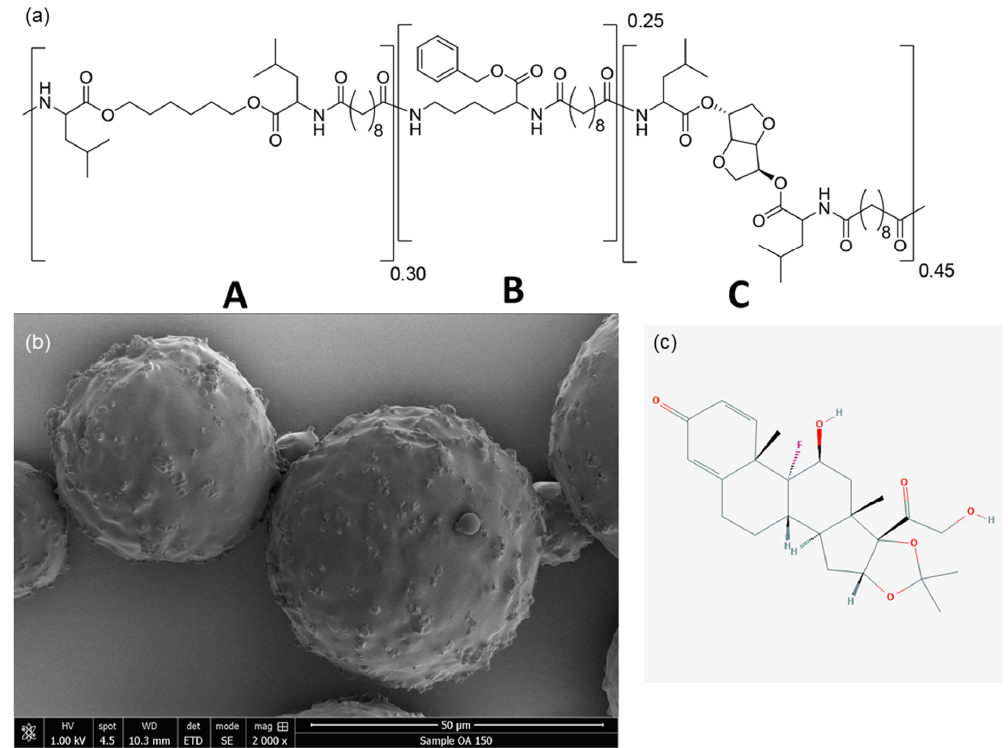
Figure 1. ( a ) Structure of polyesteramide (PEA) III Ac Bz random copolymer consisting of building blocks A, B and C (Leu, Lys, Leu). ( b ) Scanning electron microscopy (SEM) image of triamcinolone acetonide (TA) loaded microspheres. ( c ) 2D molecular formula of triamcinolone acetonide (TA) (https://pubchem.ncbi.nlm.nih.gov/image/imgsrv.fcgi?cid=6436&t=l,